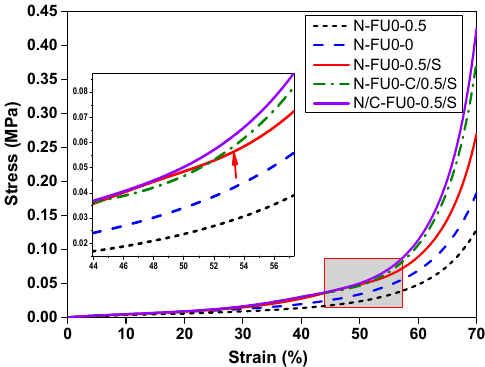
Figure 4. Stress-strain curves of MFRCs.